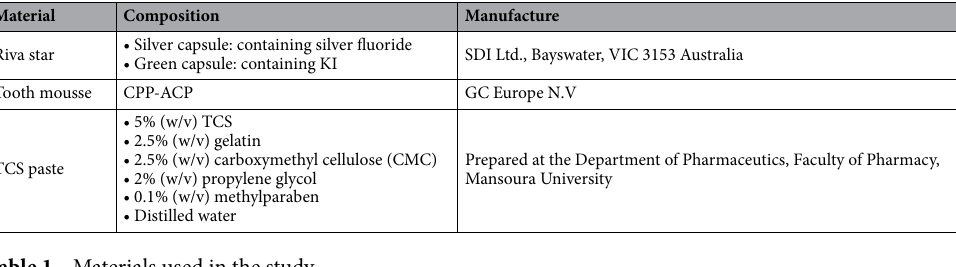
Table 1. Materials used in the